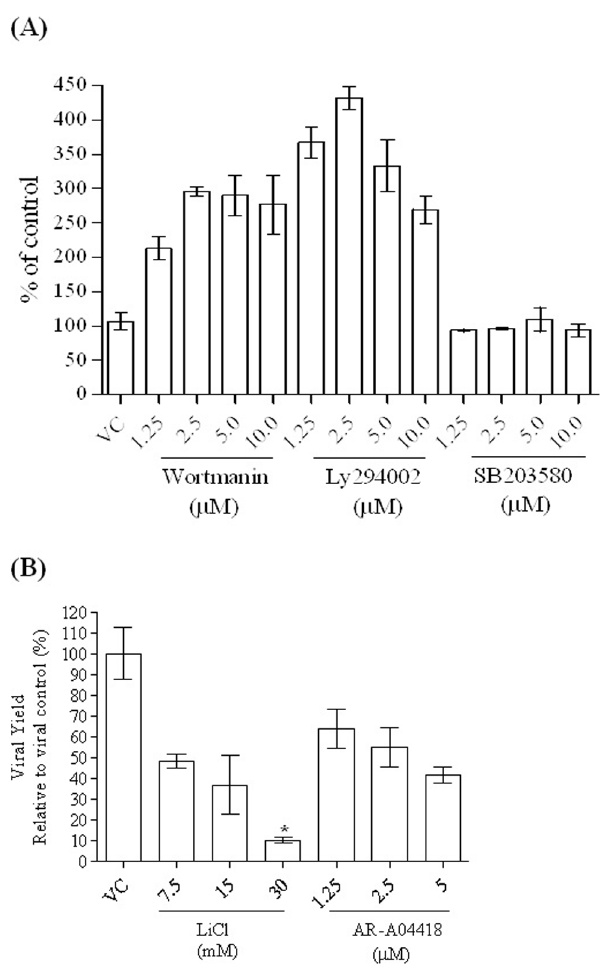
Figure 1. Pharmacological interventions targeting PI3K signal- ing affect EV-A71 replication in SF268 neural cells. The effect of PI3K (LY294002 and wortmannin), P38 MAPK (SB203580) (A) and GSK3 b (AR-A014418 and LiCl) (B) inhibitors as pharmacological interventions on the virus yields of EV-A71-infected cells was assessed. SF268 cells were infected with EV-A71 (moi 0.5), and various concentrations of compounds were added to the infected cells after 1 h viral adsorption. At 48 h post-infection, the culture supernatants and cell lysates were collected for virus titration using plaque assays. Data are displayed as mean 6 s.e.m. from at least two independent experiments performed in duplicates.